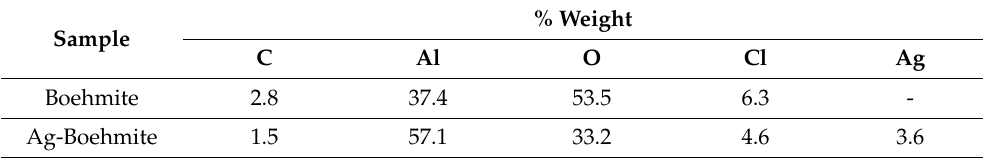
Table 2. Chemical composition of the samples according to EDS